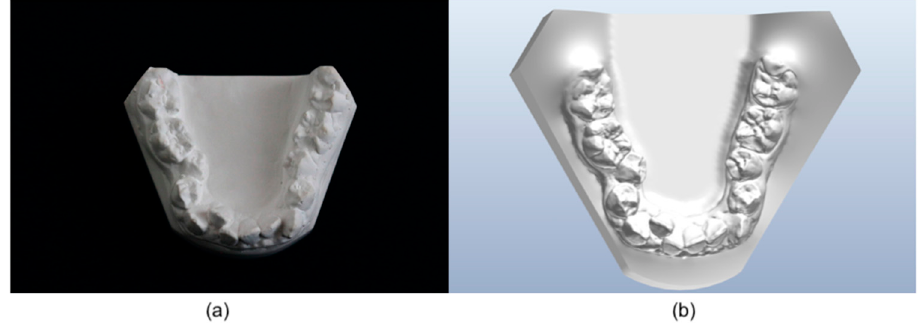
Figure 1. Example of ( a ) a real mandibular model and ( b ) a virtual mandibular model rendered by Ortho Analyzer ® (2021.1) software. Ortho Analyzer ® (2021.1)